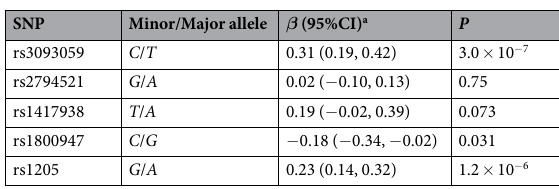
Table 3. Association of minor allele of CRP tag-SNPs with log-transformed CRP level. a The association was adjusted for gender, age, BMI, waist, SBP, DBP, hypertension, diabetes, CVD, CHOL, HDL, TG, physical activity, smoking, and alcohol drinking.